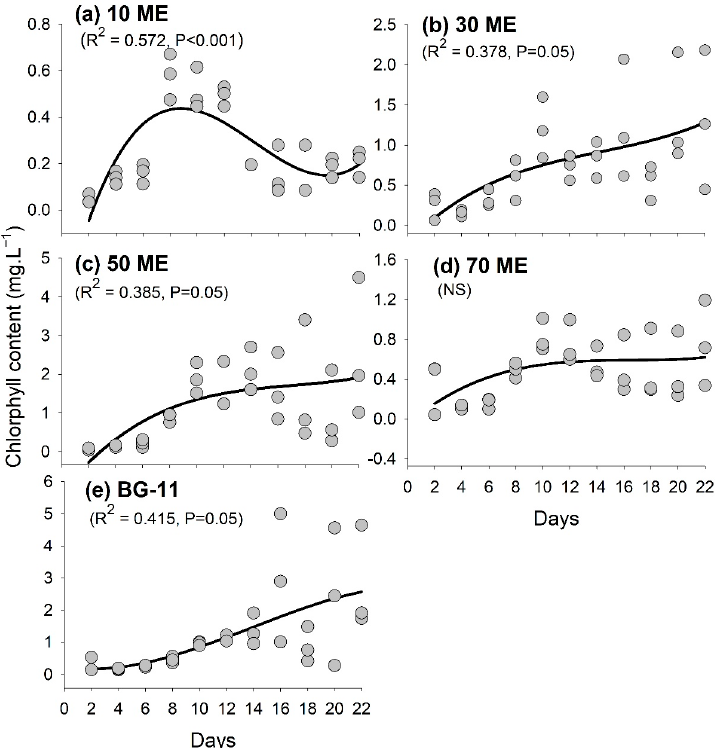
Figure 7. Variation of chlorophyll content of Chlamydomonas sp. cultivated in ( a ) 10 ME, ( b ) 30 ME, ( c ) 50 ME, and ( d ) 70 ME of malting effluent and ( e ) BG ‐ 11 standard mineral media (BG ‐ 11) during 22 days of cultivation time. The regression lines are derived from polynomial third ‐ order regression. The chlorophyll concentrations were significantly higher in Chlamydomonas sp. com ‐ pared to Chlorella sp. in all treatments (Figure 8). In our study, the amount of chlorophyll content varied between different concentrations of malting culture medium and species. Chlamydomonas sp. have the potential to survive in higher nutrient conditions and pro ‐